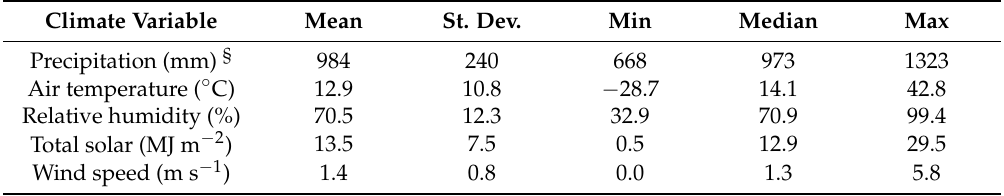
Table 2. Summary of daily climate statistics at a United States (US) Geological Survey gauging site (Site #4) in Hinkson Creek, Missouri,